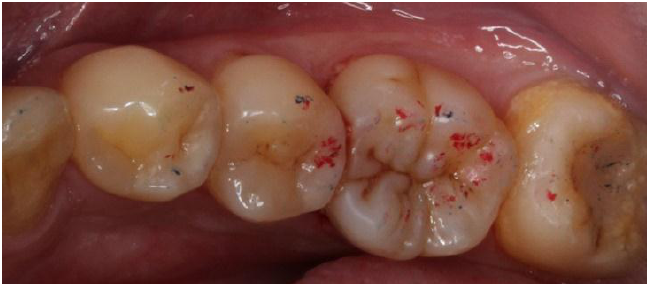
Figure 5. Cementation under rubber dam isolation: ( a ) before cementation; and ( b ) after cementation.